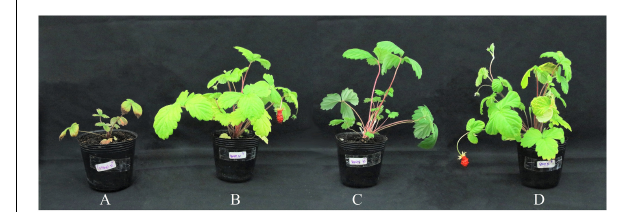
FIGURE 3 | Performance of strawberry plants inoculated with DSE fungal isolates under Fof challenge in inorganic commercial soil (A) Control plants. (B) Plant treated with Exophiala sp. SK47. (C) Plant treated with E. pisciphila SK48. (D) Plant treated with C. chaetospira SK51. All plants were infested with Fof, including the control